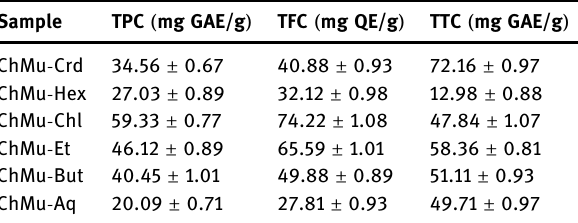
Table 2: Quantitative spectrophotometric analysis of phytochem - ical in crude extract and fractions of C. murale Sample